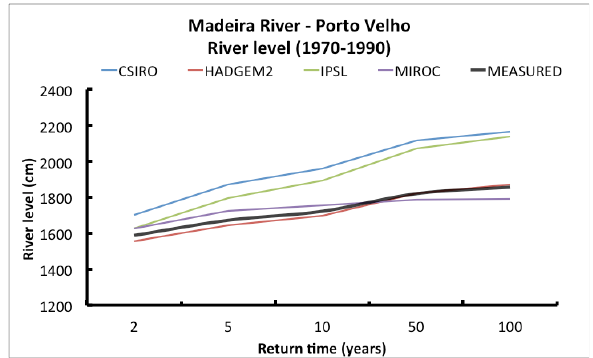
Figure 1: Maximum river levels estimated for different return times using measured gauge station data and hydrological simulation based on several climate models data for the historical period (1970-1990).